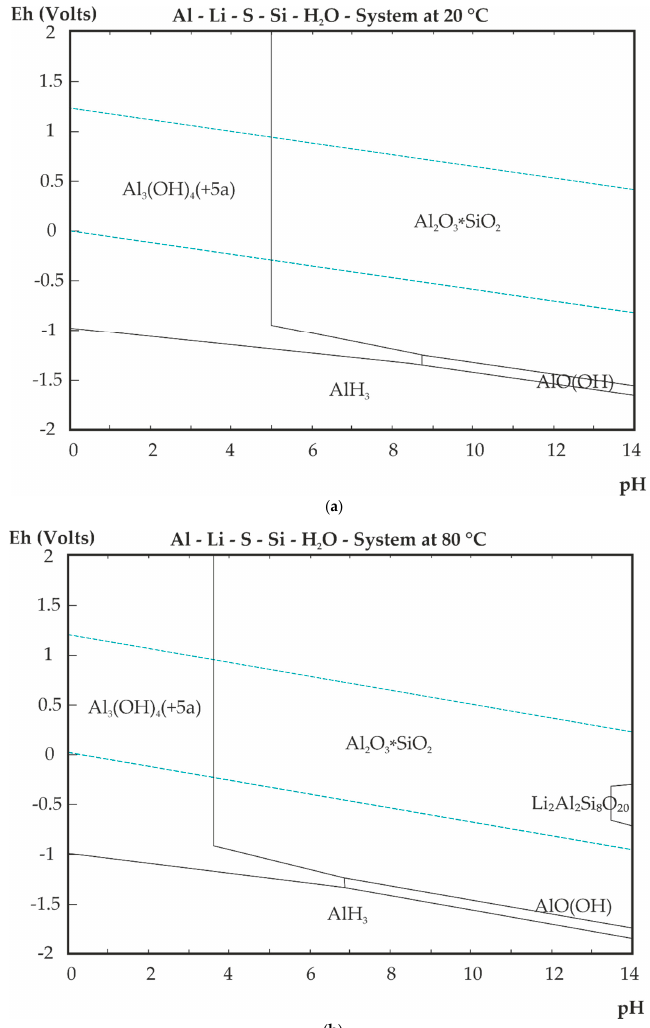
Figure 4. Eh-pH diagram for Li-Al-S-Si-H 2 O system: ( a ) 20 °C, ( b ) 80 °C. Molarity: (Li) = 1 M, (Al) = 0.5 M, (S) = 0.5 M and (Si) = 0.05 M.